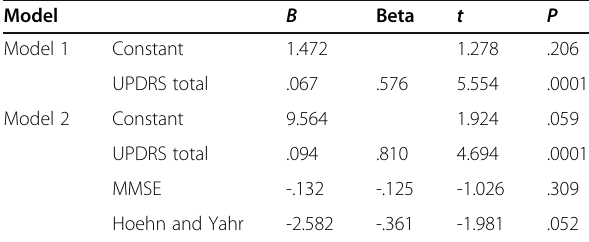
Table 5 Hierarchical multivariable regression analysis for depression Model